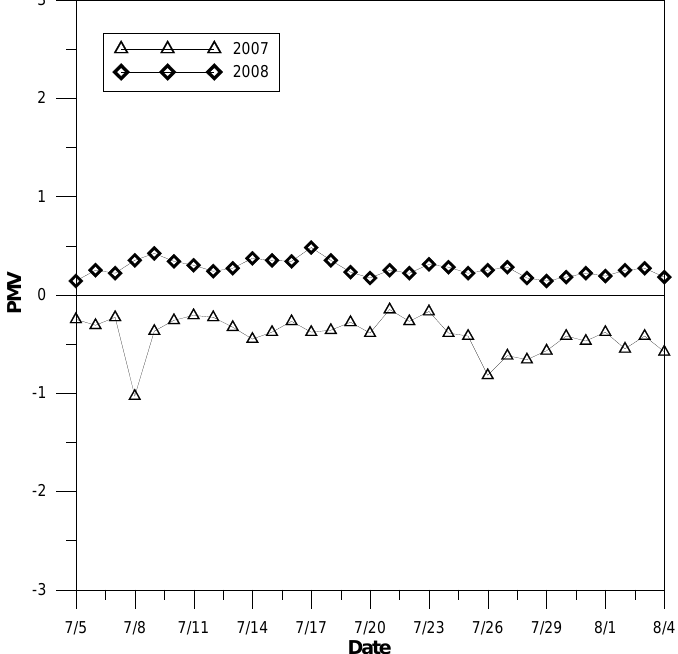
Figure 9. The PMV control in a convenience store based on the feedback of energy harvesting sensor network and its comparison to the PMV without control.